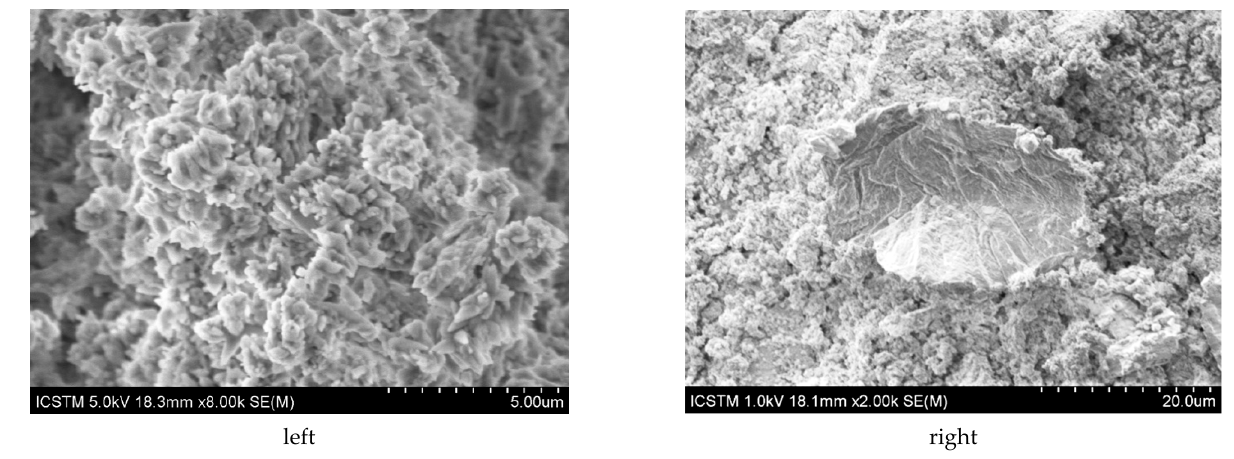
Figure 6. The SEM images for the area with gypsum ( left ) and with waxes ( right ).